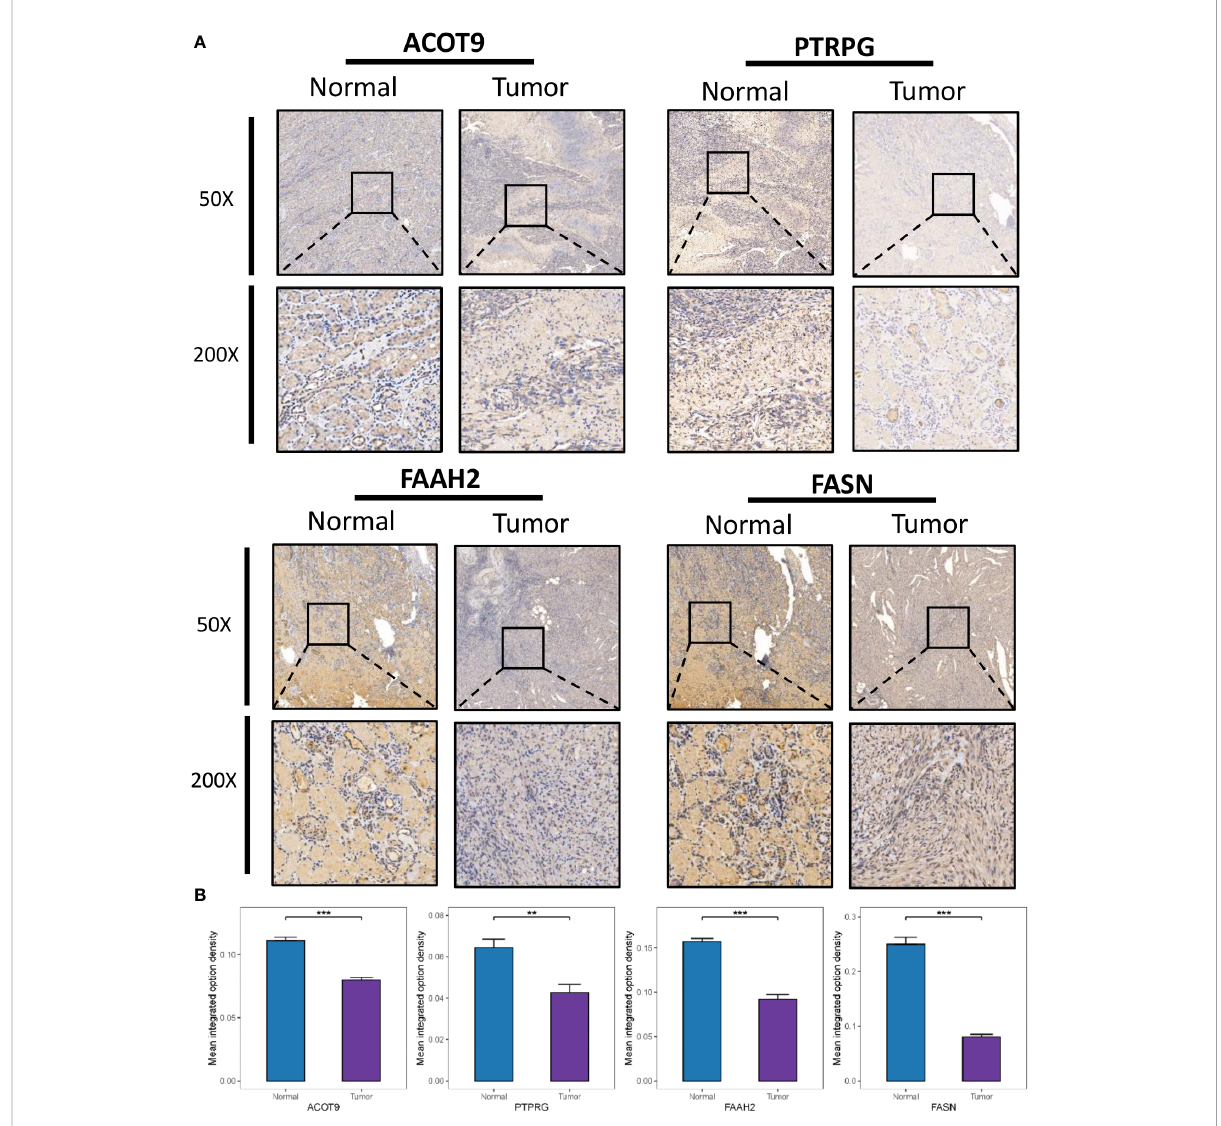
FIGURE 9 Clinical Validation of the risk model based on IHC. (A) Representative IHC images of the four selected gene. (B) The quantitative expression levels of each gene. ** P < 0.01; *** P <